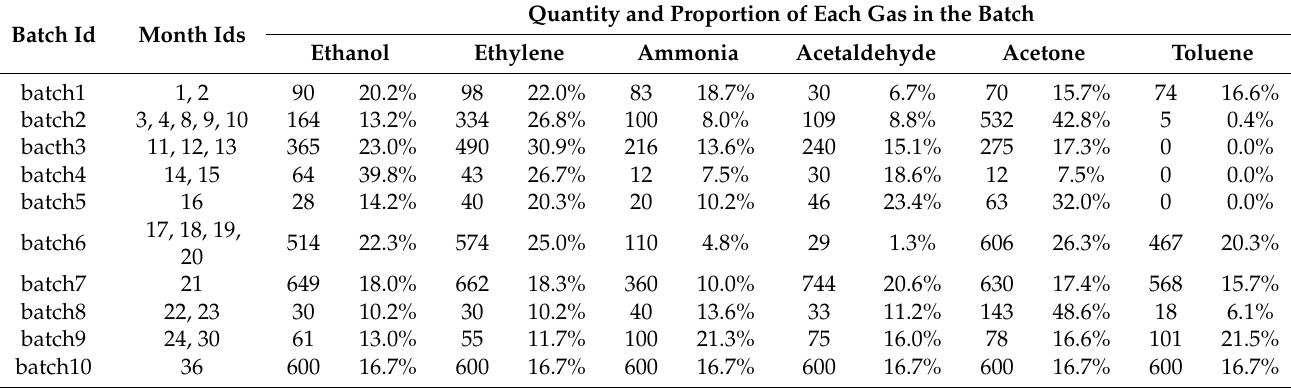
Table 1. Data distribution of each batch in the GSAD dataset.